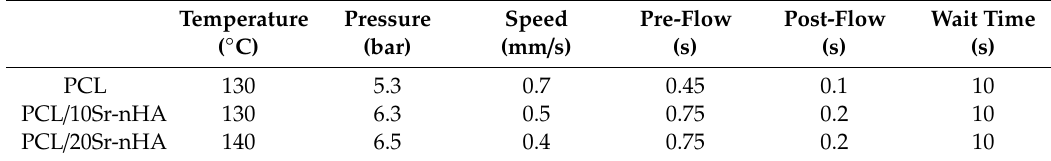
Table 2. 3D printing